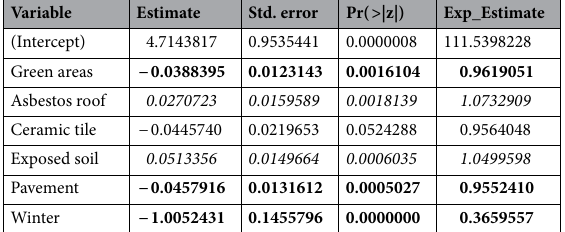
Table 1. Estimates of model parameters, standard error, and p -values. The variables in bold showed a negative association with the number of mosquitoes, while those in italics showed a positive association.